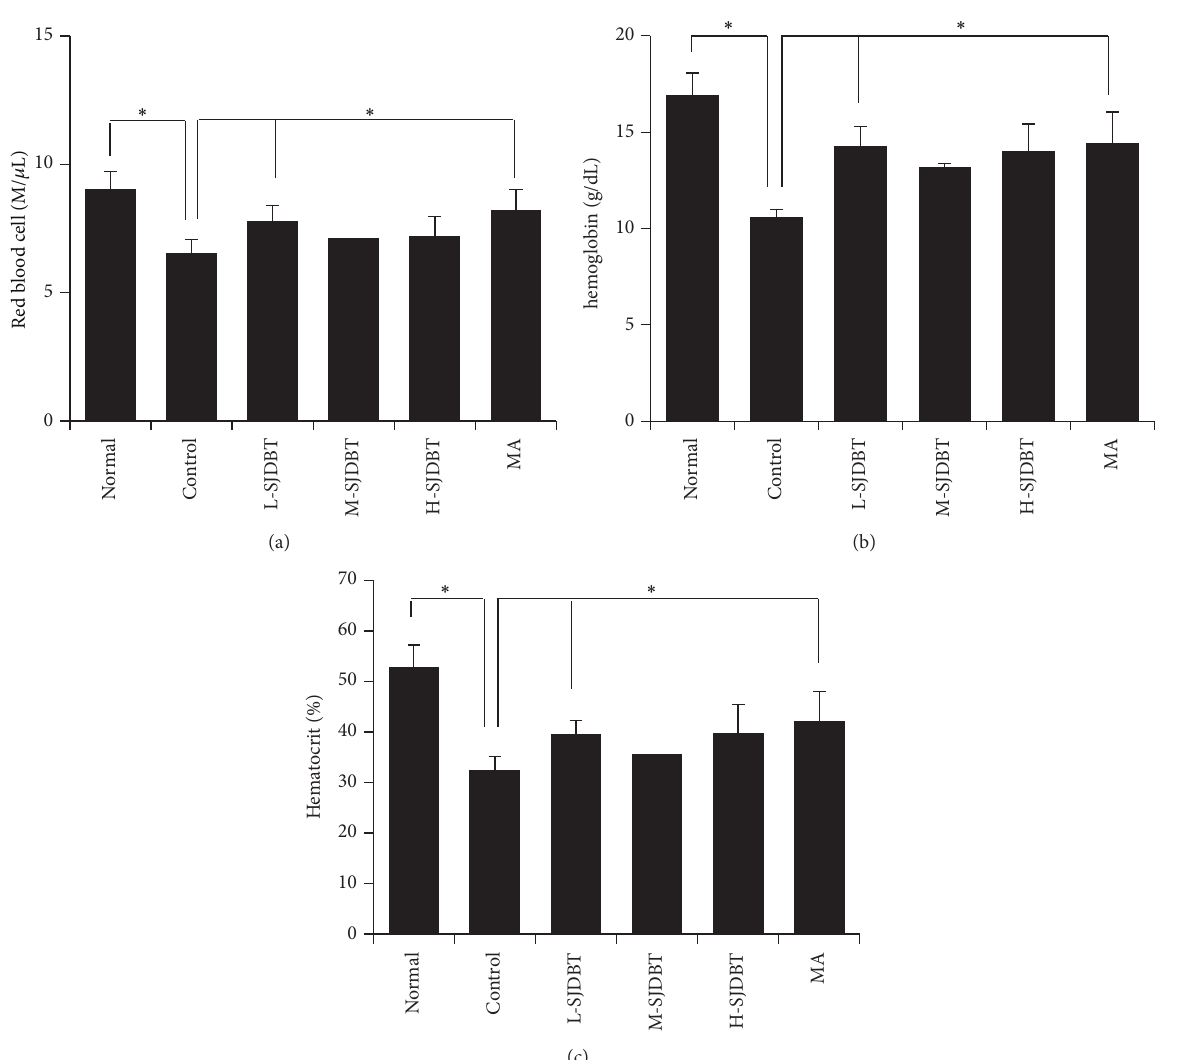
Figure 5: Blood analysis. ((a), (b), and (c)) 21 days after tumor cell injection, SJDBT were p.o. administrated for 21 days. At the end of experiments, mice were sacrificed. Whole blood samples were collected by cardiac puncture. The blood was placed in Vacutainer TM tubes containing EDTA (BD science, NJ, USA). Blood analysis was performed using the HEMAVET 950 hematology analyzer (Drew Scientific, Inc., Oxford, CT, USA) in accordance with manufacturer’s